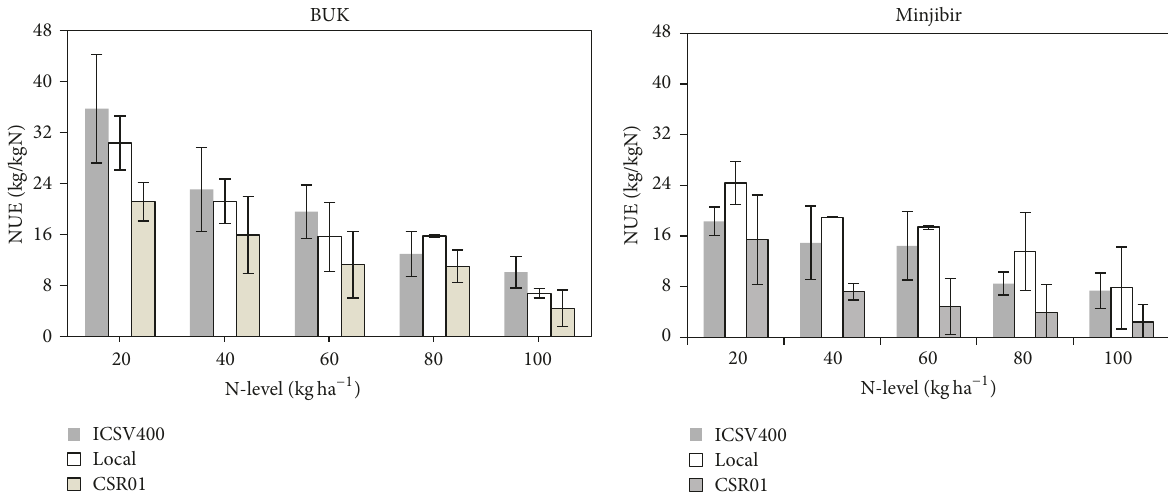
Figure 3: Effects of N-fertilizer rates on nitrogen use efficiency (NUE) of selected sorghum varieties in Sudan Savanna zone. P of F equals 0.574 in BUK and 0.017 in Minjibir